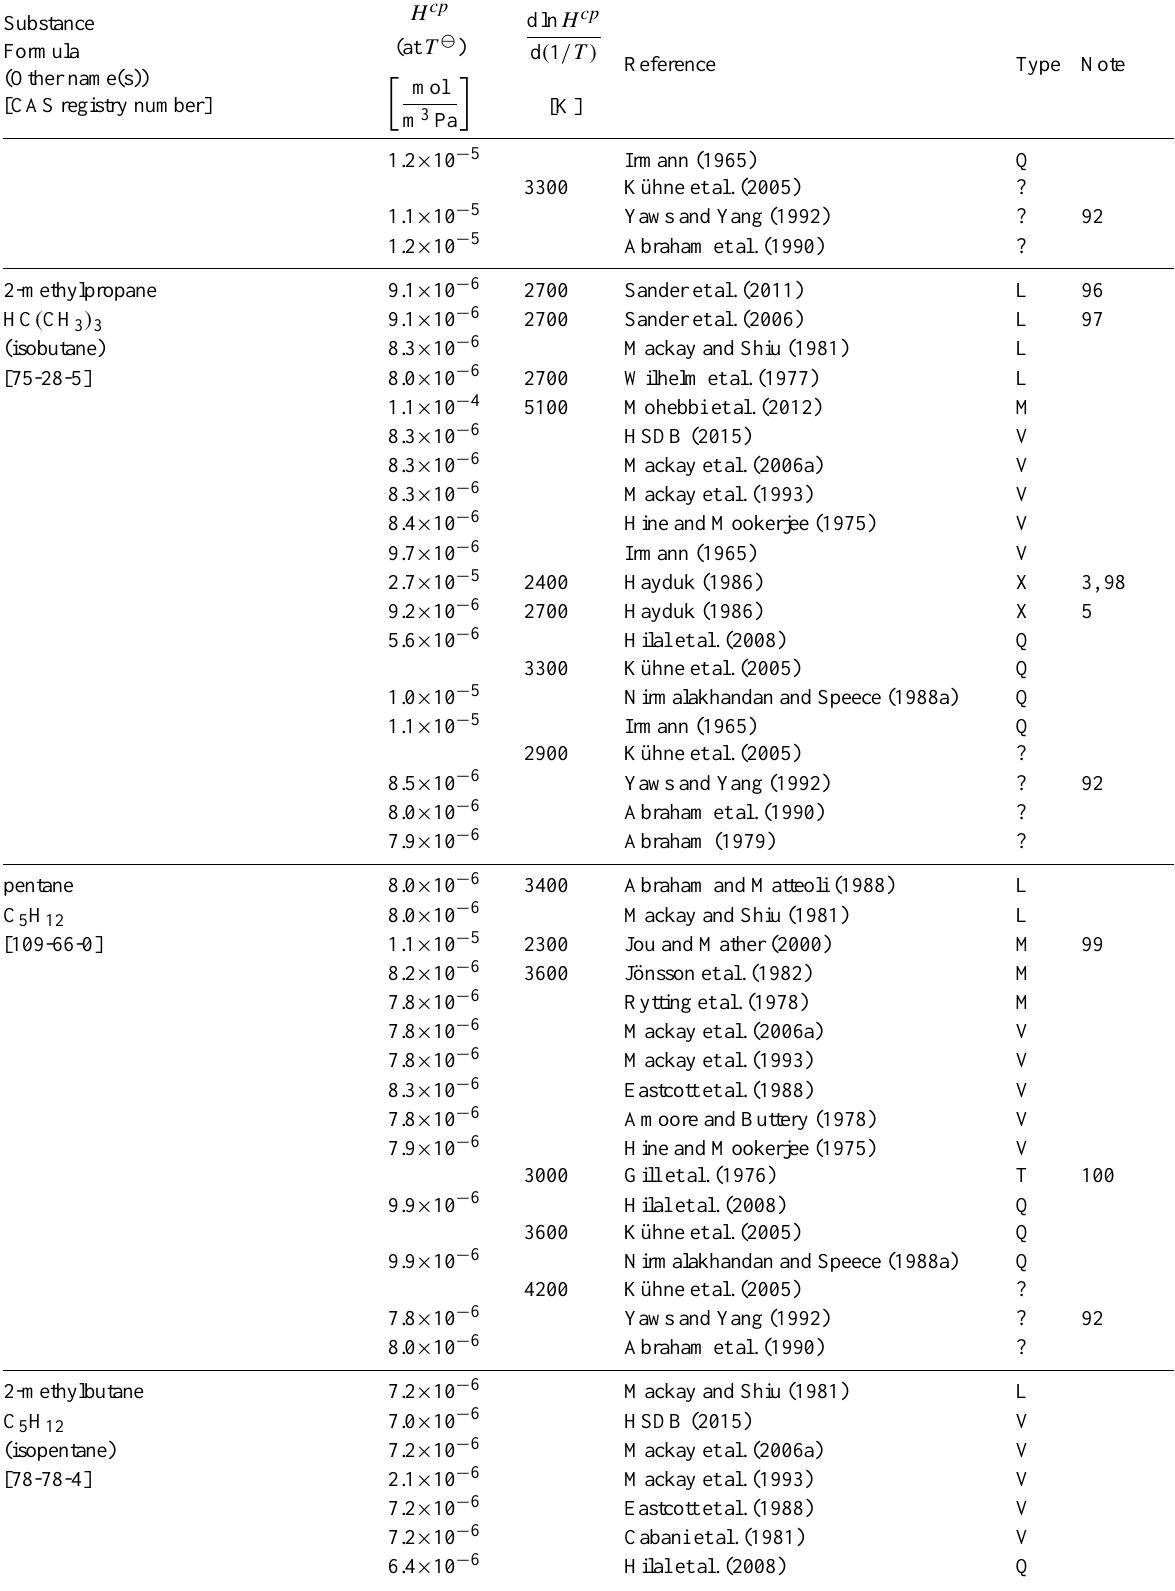
Table 6: Henry’s law constants for water as solvent